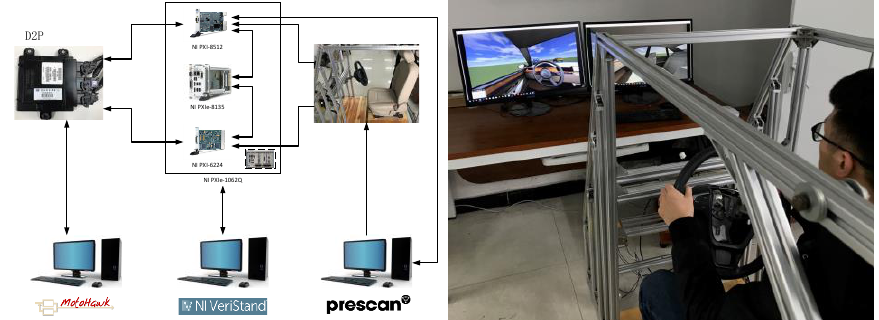
Figure 11. Driver-in-the-loop hardware-in-the-loop (HIL) test platform.